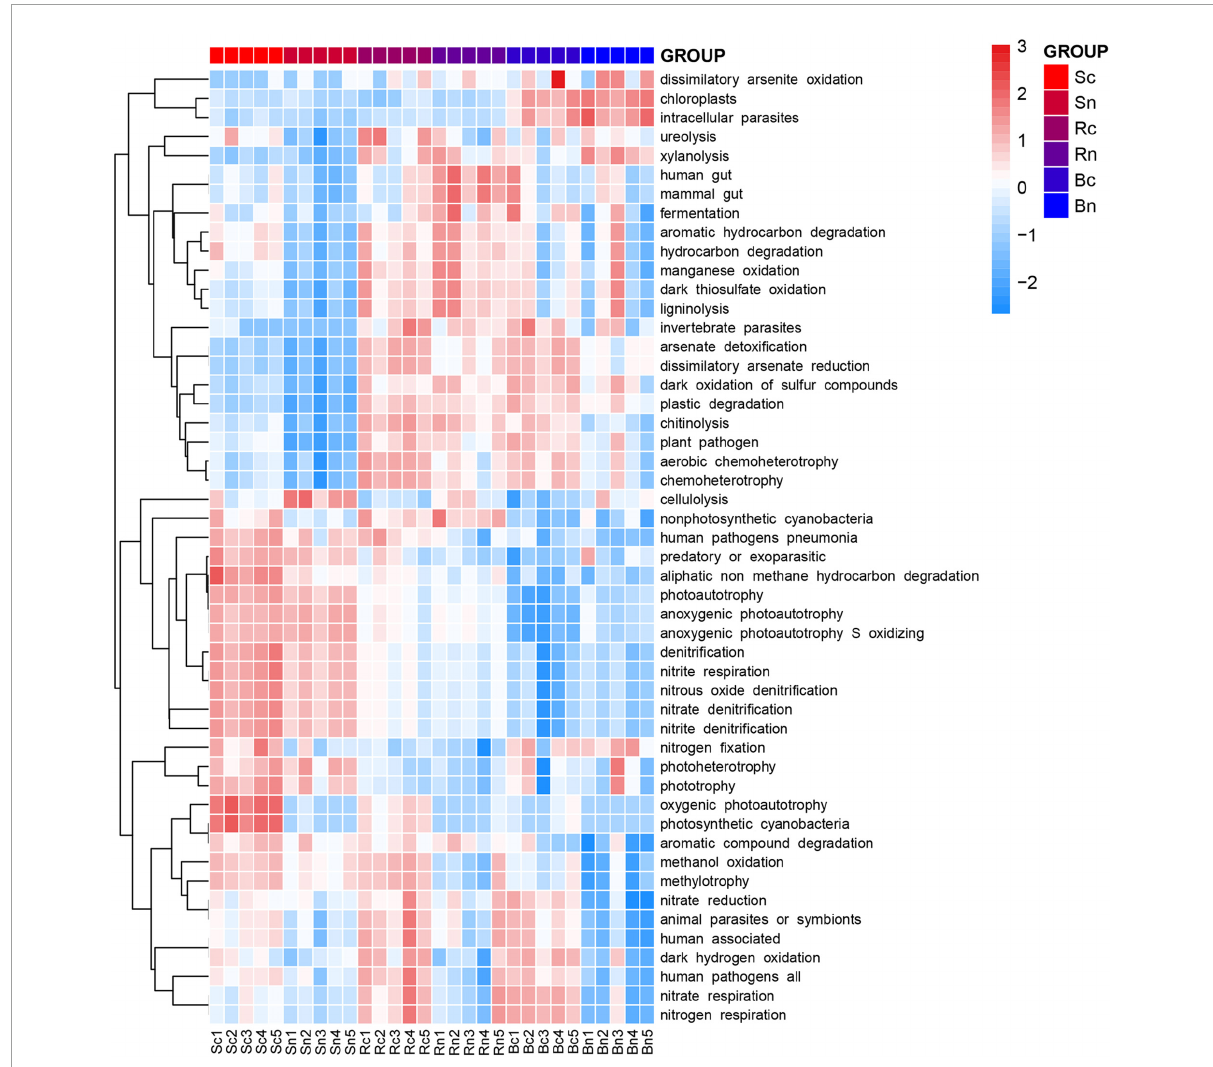
FIGURE7 Heatmap of the predicted functional profile for the microbial communities at OUT level based on the Functional Annotation of Prokaryotic Taxa (FAPROTAX 1.1) database. The color code indicated relative abundance, ranging from blue (negative correlation) to red (positive correlation). Sc, continuous cropping bulk soil; Sn, non-continuous cropping bulk soil; Rc, continuous cropping rhizosphere soil; Rn, non-continuous cropping rhizosphere soil; Bc, continuous cropping sugar beetroot; Bn, non-continuous cropping sugar